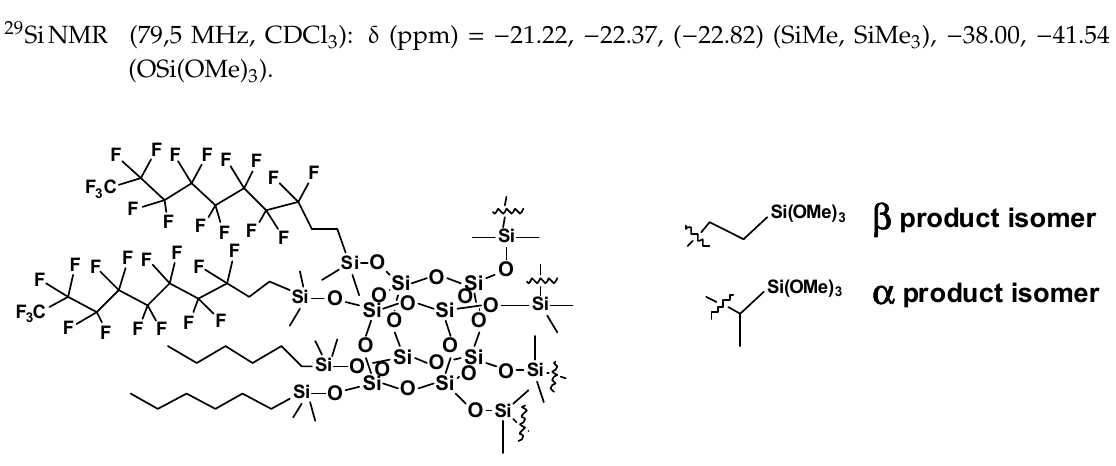
Figure 3. Structure of bis(3,3,4,4,5,5,6,6,7,7,8,8,9,9,10,10-hexadecafluorodecyldimethylsiloxy) bis(hexyl dimethylsiloxy)tetrakis((trimethoxysilyl)ethyldimethylsiloxy)pentacyclo[9.5.1.13,9.15,15.17,13]octasiloxane.